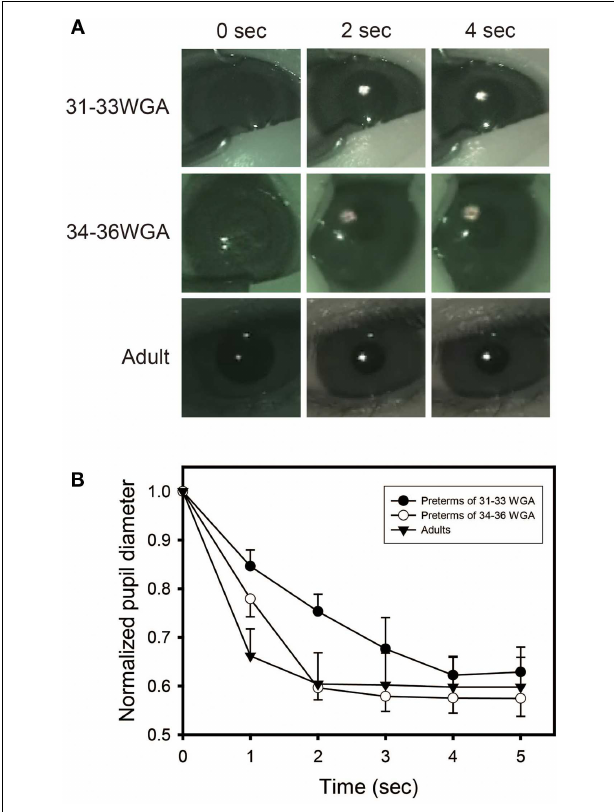
FIGURE 5 | Preterm infants of 31–33weeks’ gestational age exhibit no pupillary light reflex (PLR) to 600nm-monochromatic light . (A) Pupillary constrictions in response to 5s of 600nm-monochromatic light (quartz halogen source, 7.57 µ W/cm 2 ) in preterm infants and adults were examined. Preterm infants of 31–33weeks’ gestational age exhibit no PLR to 600nm-monochromatic light while preterm infants of 34–36weeks’ gestational age and adults showed PLRs. (B) Time courses of PLRs in preterm infants and adults to 600nm-monochromatic light (quartz halogen source, 7.57 µ W/cm 2 , 5s). For details, see the legend of Figure 4